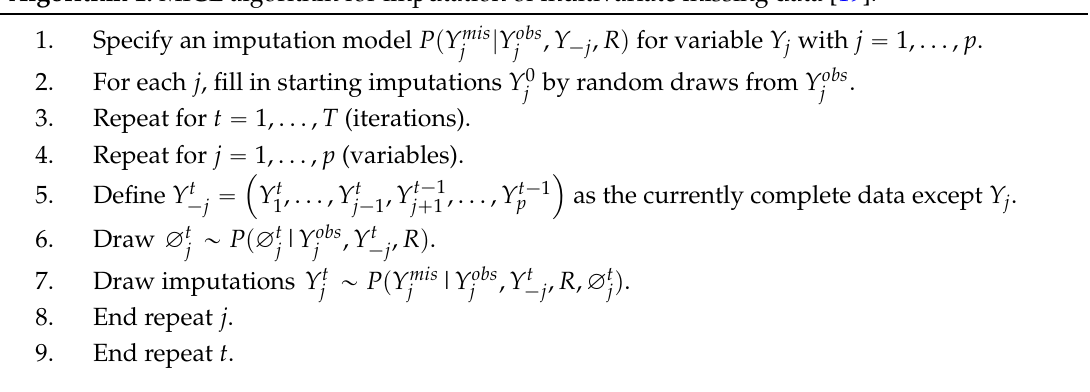
Algorithm 1: MICE algorithm for imputation of multivariate missing data